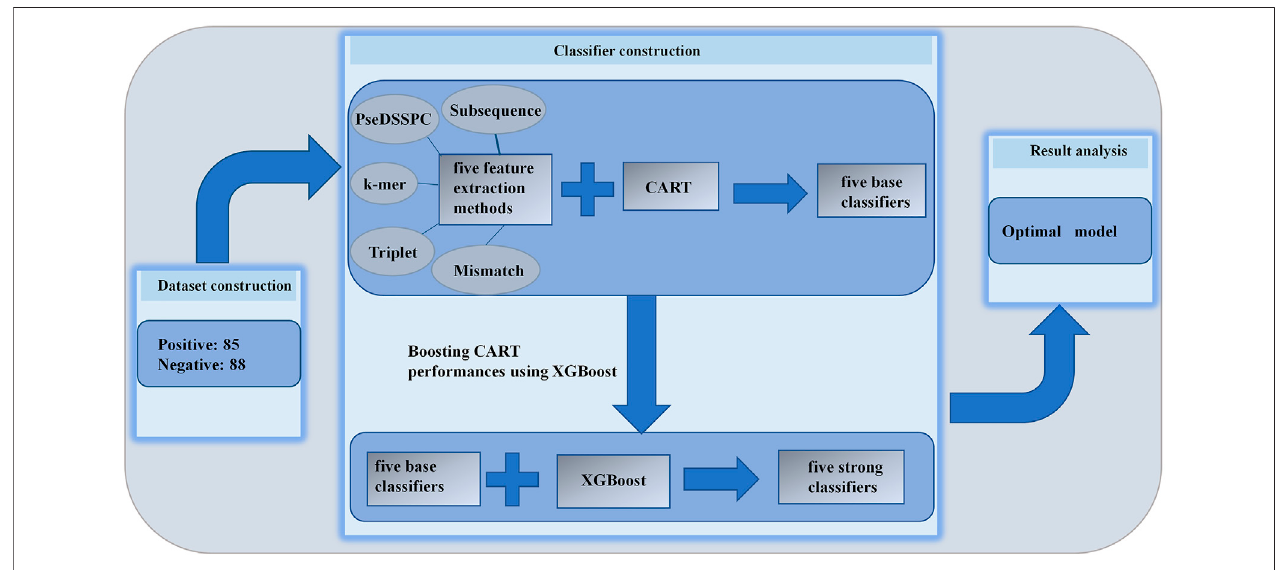
FIGURE 1 | Overall fl owchart of our method.